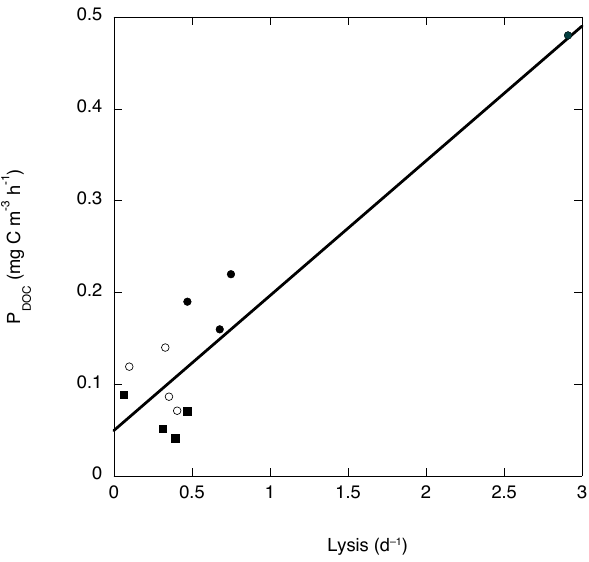
Fig. 8. The relationship found between dissolved organic car- bon production by phytoplankton and lysis rates ( R 2 = 0.76, p < 0.0005). Data from AE (full circles), CE (open circles) and FF (full squares)